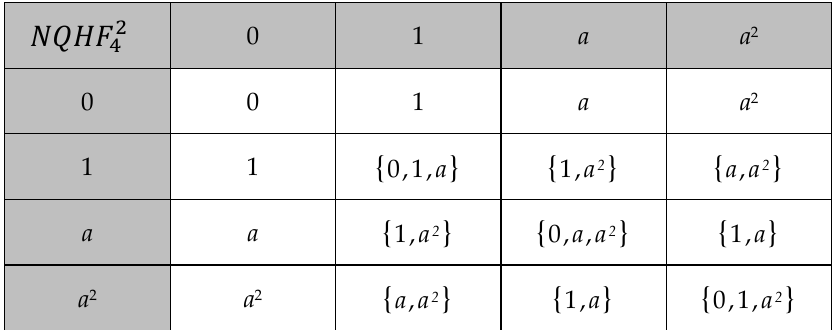
Table 11. The Cayley table of the additive canonical hypergroup of the non-quotient hyperfield 𝑁𝑄𝐻𝐹 42 .